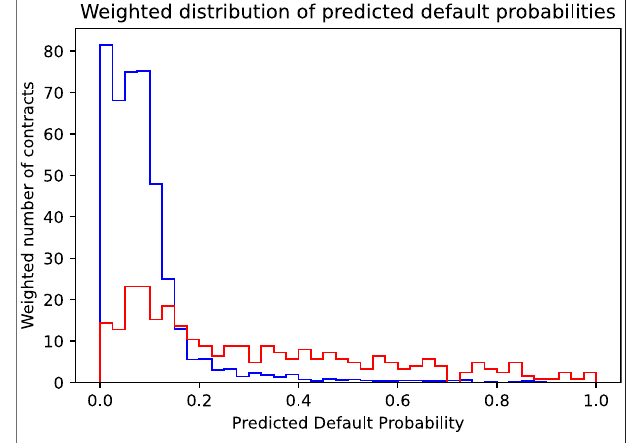
FIGURE 4 | Shown is the distribution of the predicted default probabilities, where the distribution for the actually non-defaulting contracts (blue histogram) is weighted by their income (corresponding to the risk premium plus the spread) and the distribution of the actually defaulting contracts (red histogram) is weighted by their loss (corresponding to the face value reduced by the recovery